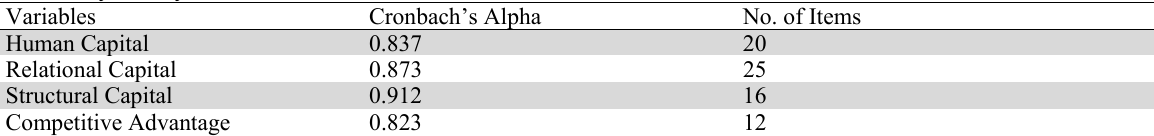
Reliability Analysis